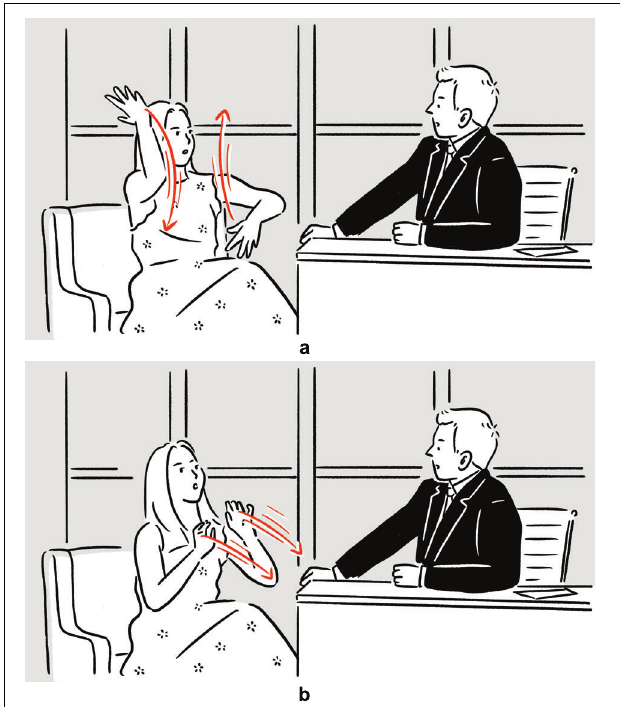
FIGURE 2 | Depictions in (6).